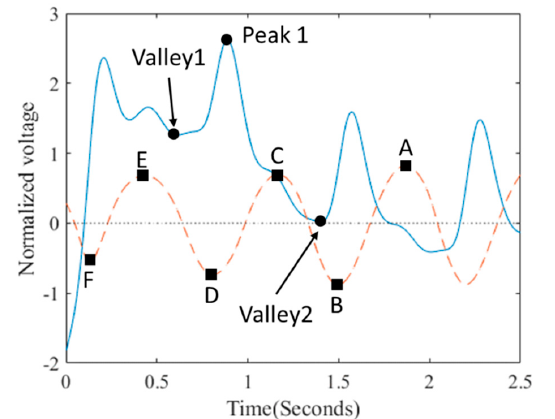
Figure 4. The peak and two side valleys (Valley1 and Valley2) of the PPG pulse (solid line) have the same signs. Its smoothed PPG signal (dashed line) is same as the smoothed PPG signal without the wandering noise.